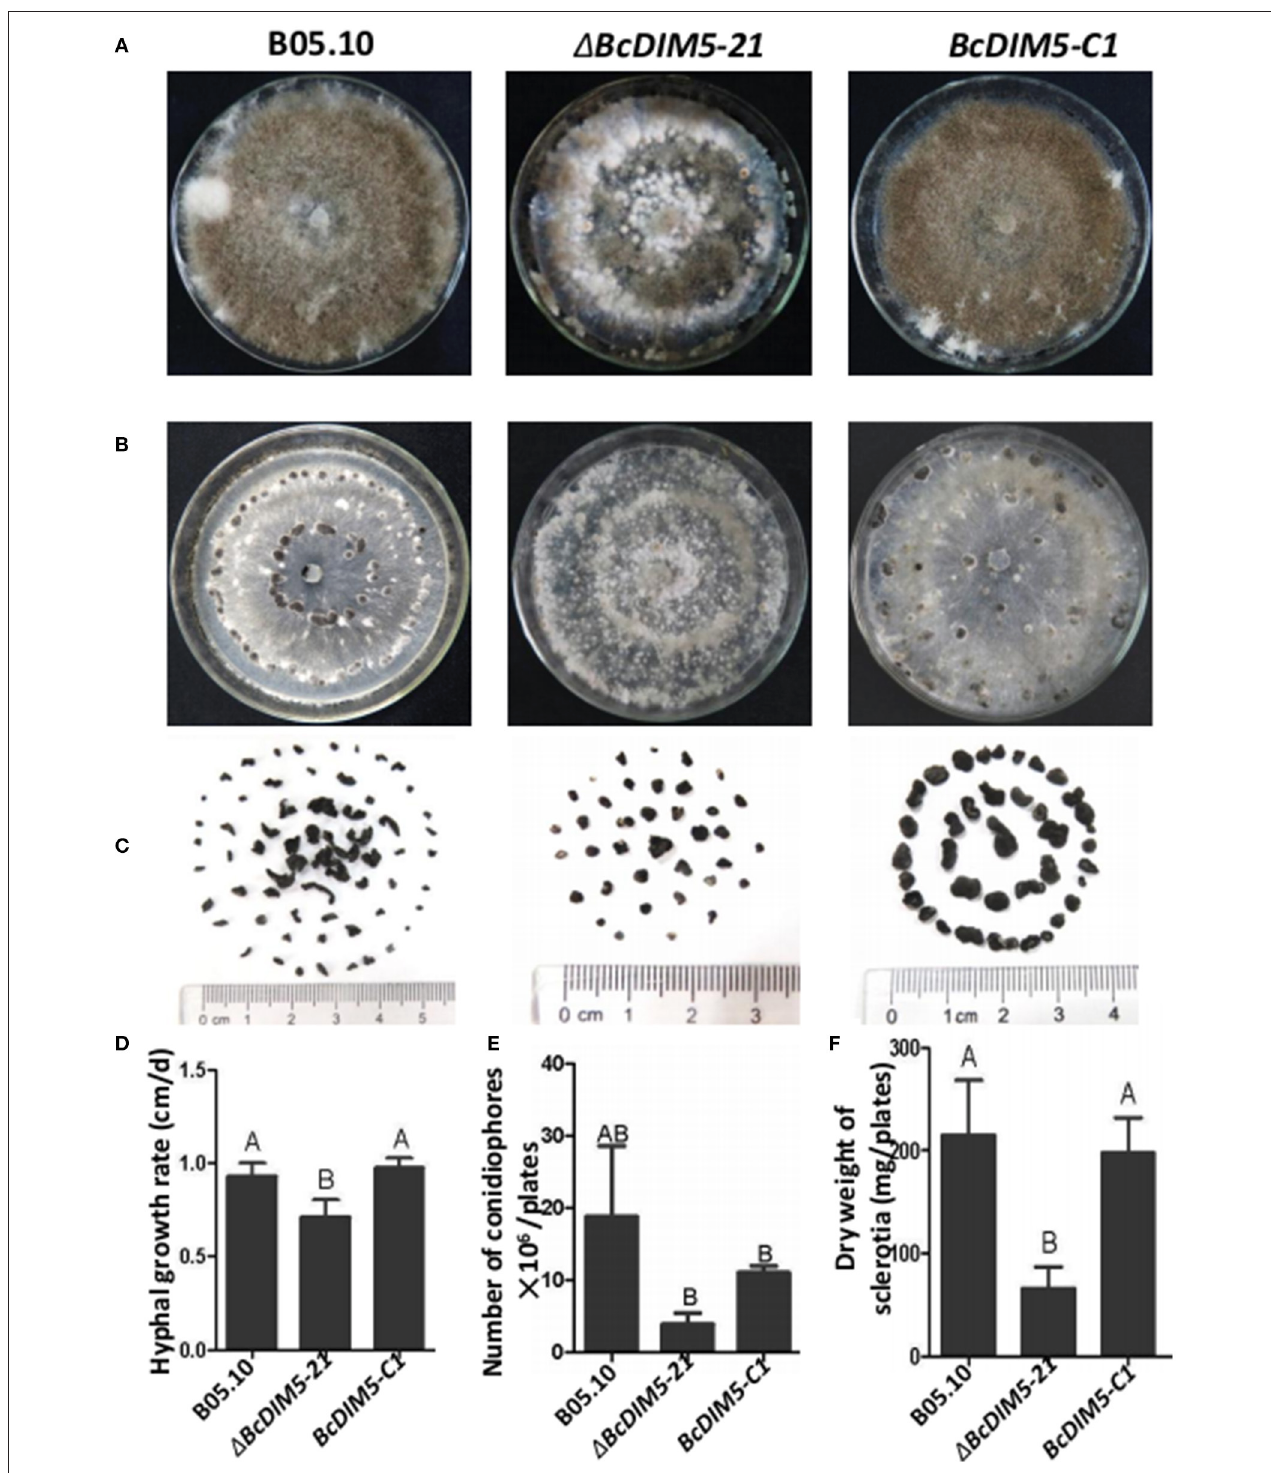
FIGURE 2 | Biological characterization of the wild-type strain, BcDIM5 knockout, and complemented transformants. (A) Comparison of the phenotypes of the BcDIM5 knockout and complemented strain. All the strains were grown on a PDA plate at 20 ◦ C for 15 days under a 12h light/12h dark photoperiod. (B) Comparison of the phenotypes of the BcDIM5 knockout and complemented strain. All the strains were grown on a PDA plate at 20 ◦ C for 15 days under dark condition. (C) Sclerotia produced by strains on a PDA plate at 20 ◦ C for 30 days under dark condition. (D) Comparison of the hyphal growth rate of the